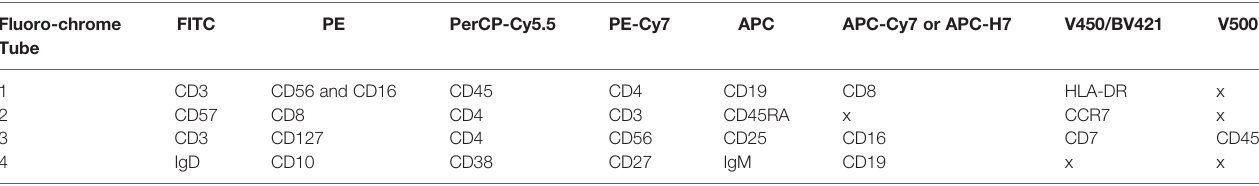
TABLE 1 | Panel of four antibody combinations used in the